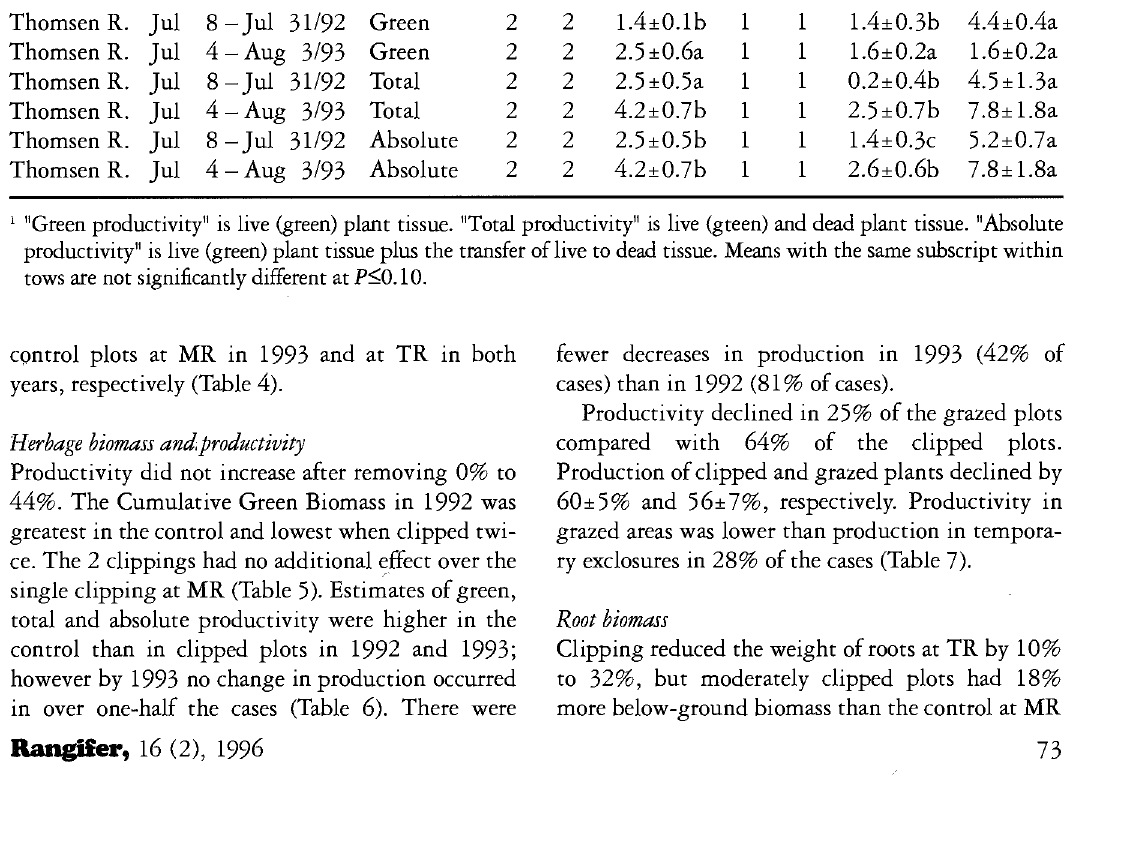
Table 6. Mean (±SE) green, total and absolute productivity estimates 1 (g m' 2 d" 1 ) among treatments in 1992 and 1993 lm x lm plots («=5) inside permanent